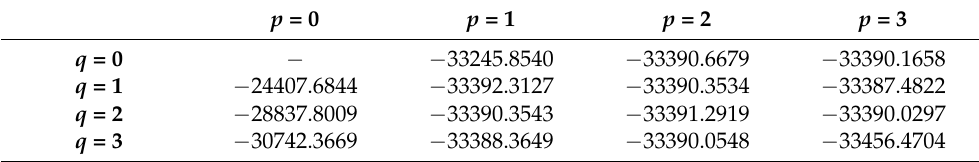
Table A7. AIC values of x -axis BiLSTM network results at each order.